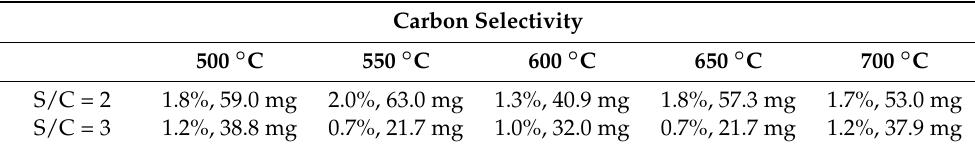
Table 2. Carbon selectivity on the used methane 10%Ni/Al 2 O 3 catalyst reacted at 500–700 ◦ C at S/C of 2 and